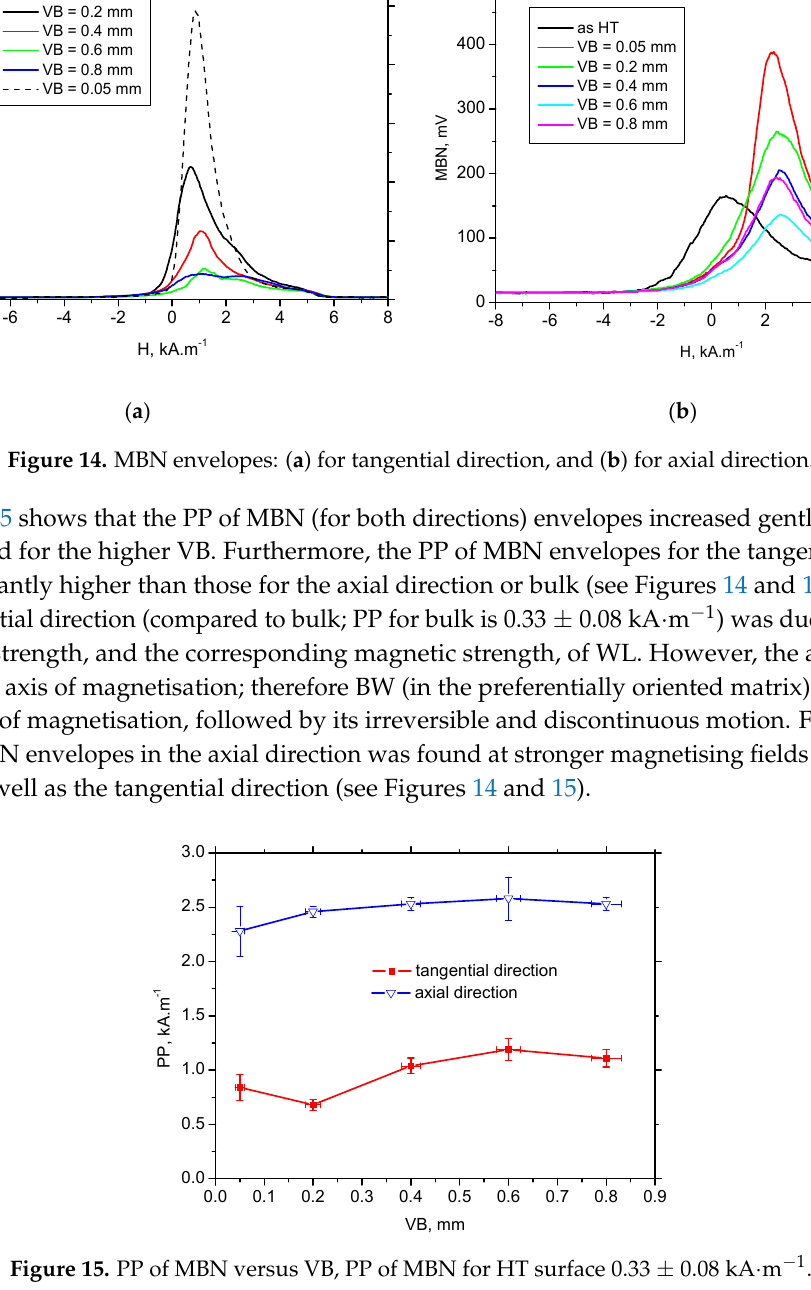
Figure 13. MBN for tangential and axial directions, MBN for HT surface 100 mV.